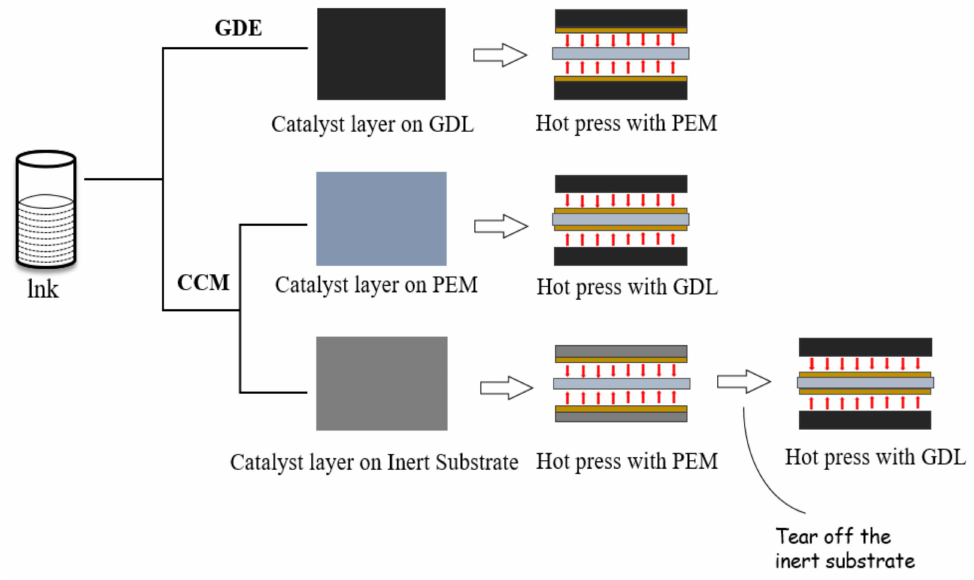
Figure 9. Schematic diagram of CL preparation process [169]. Copyright 2018